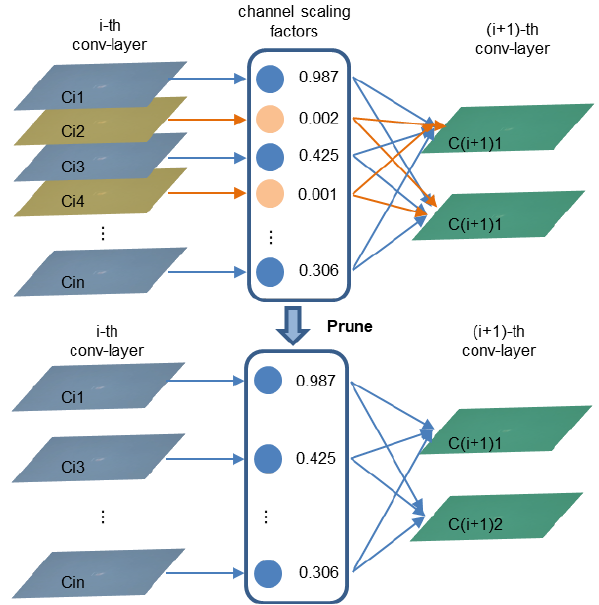
Figure 12. The model is compressed by pruning. During training, the model automatically recognizes unimportant channels. The channels with small scaling factor will be pruned. After pruning, the model will be more compact, occupy less memory and run faster, without loss of accuracy.